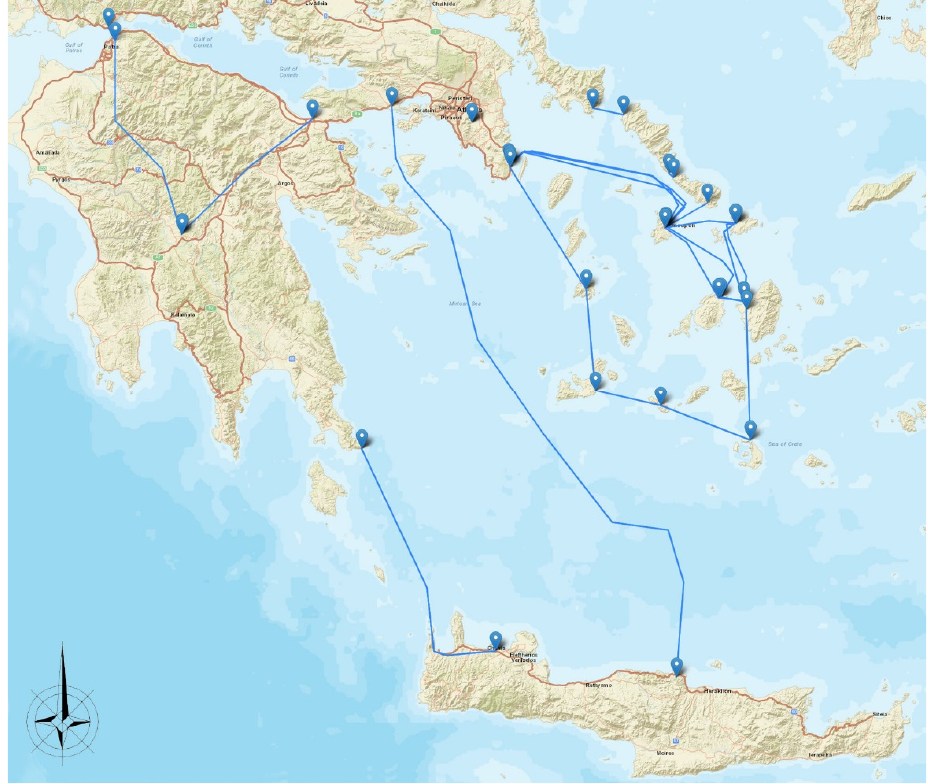
Figure 6. Electrical interconnections already completed or started of the Greek islands with the mainland grid [59].